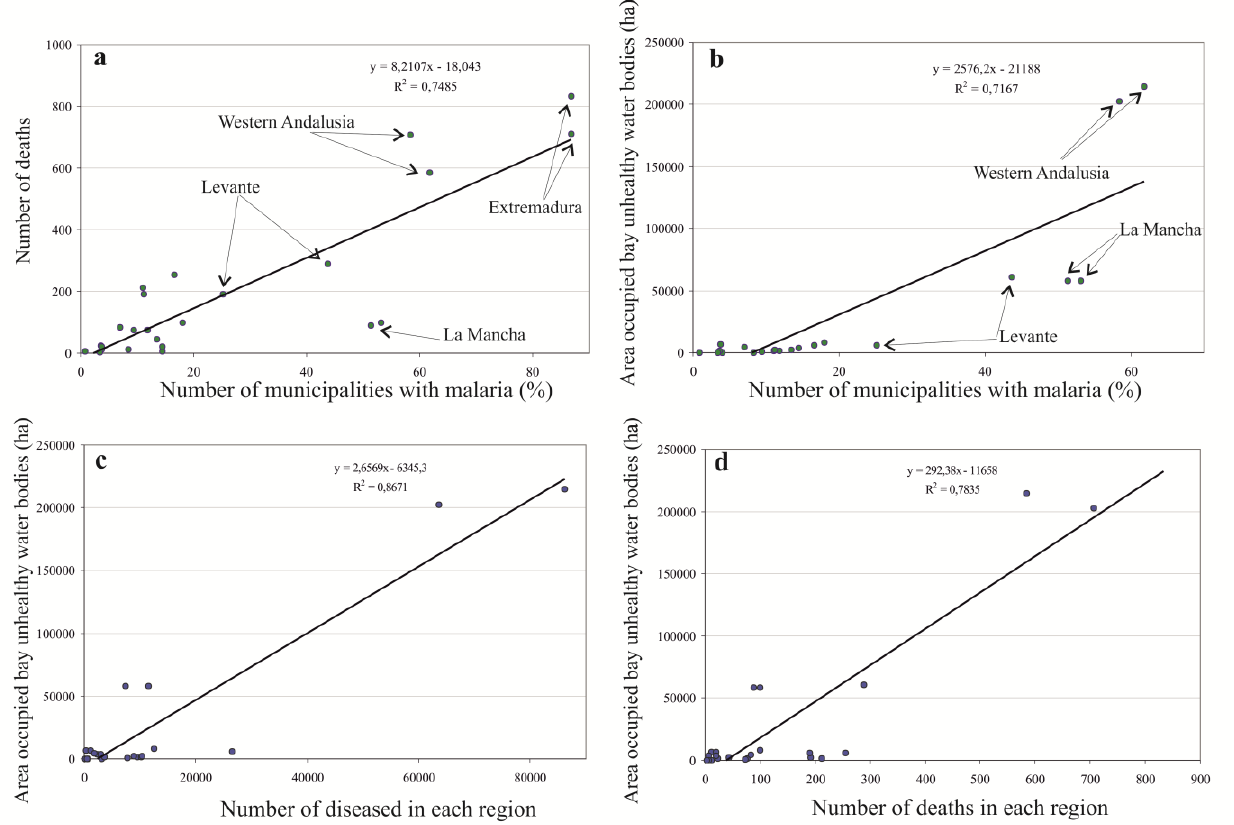
Figure 4. ( a ) Correlation between the number of deaths and the percentage of malarial municipalities. ( b ) Correlation between the area of unhealthy liquid collections and the percentage of malarial municipalities. ( c ) Correlation between the area of unhealthy liquid collections and the number of diseased people. ( d ) Correlation between the area of unhealthy liquid collections and the number of